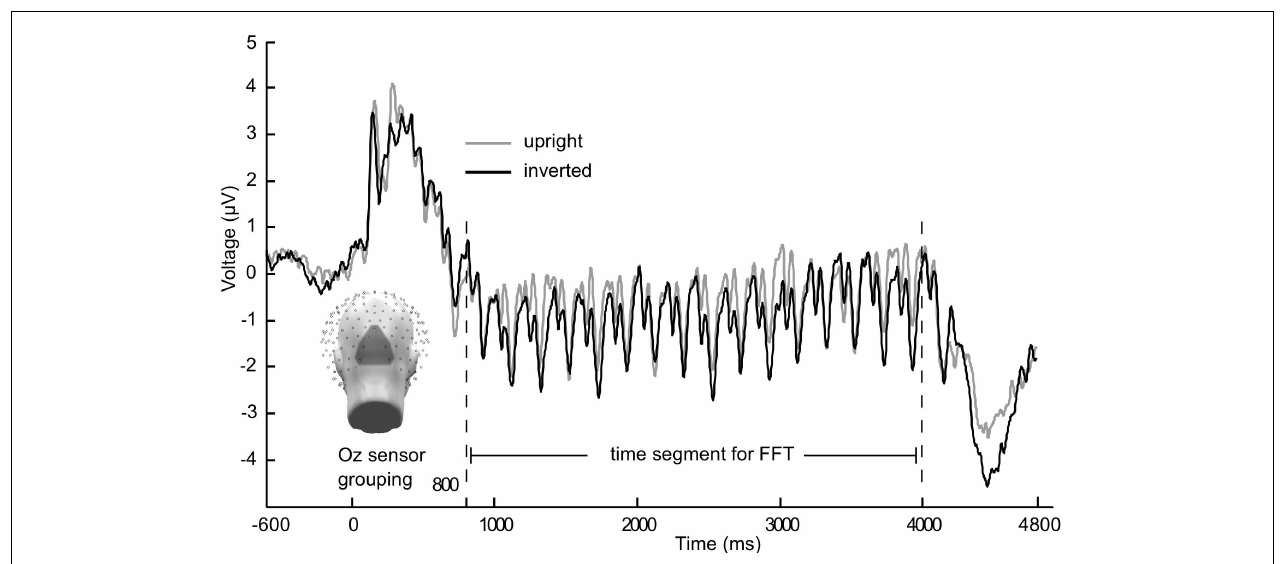
frequencies in the time domain averaged data, as grand mean may include differing phases (across participants) and conversion into the frequency domain along with statistical analyses is necessary before making inferences about multiple frequencies contained in the